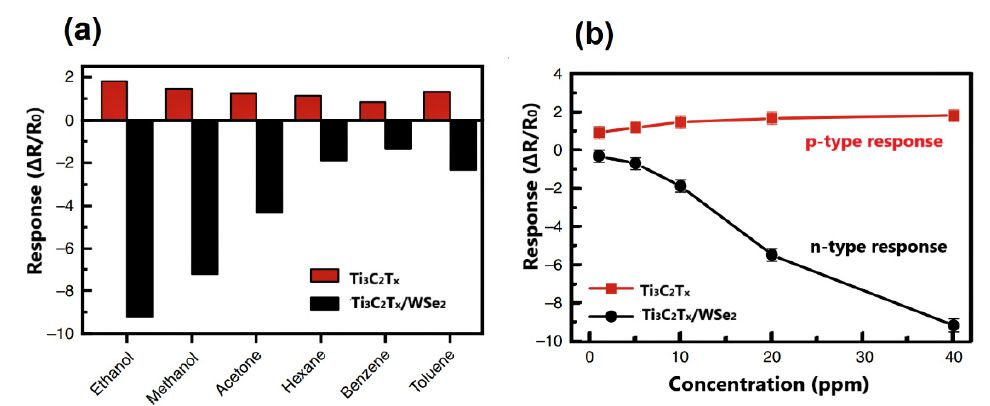
Figure 19. ( a ) Gas sensor response of Ti 3 C 2 T x and Ti 3 C 2 T x /WSe 2 sensors to different gases with a concentration of 40 ppm. ( b ) Gas sensor response of Ti 3 C 2 T x and Ti 3 C 2 T x /WSe 2 sensors to ethanol